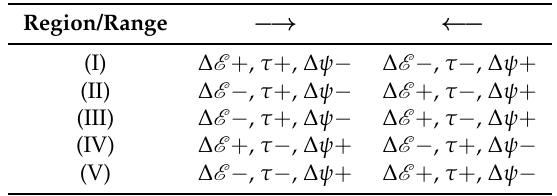
Table 2. Behaviour of physical parameters ∆ E , τ and ψ in different regions.